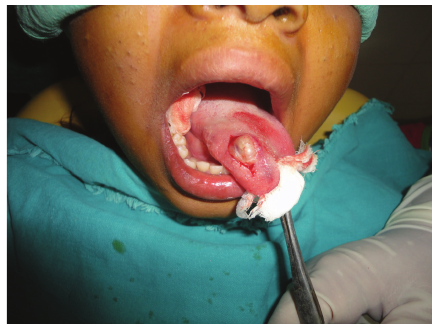
Figure 2: Encapsulated mass.